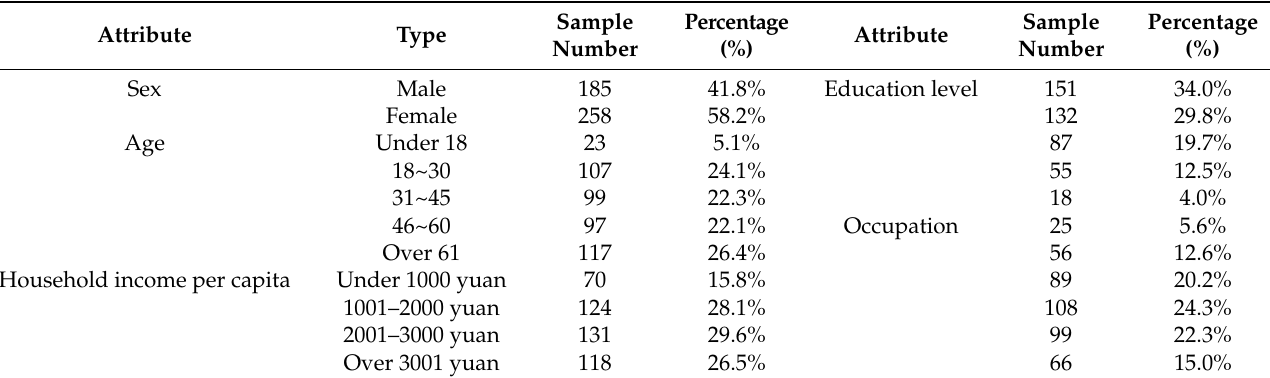
Table 3. Characteristics of the